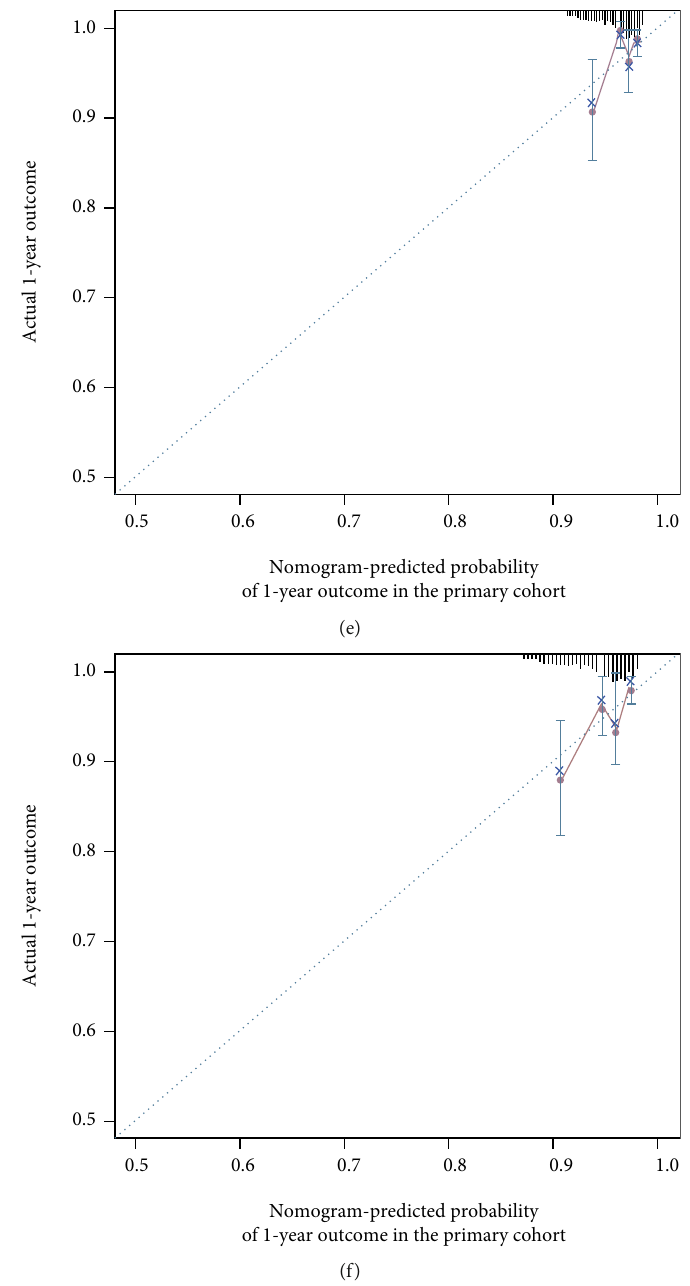
Figure 3: The calibration curve for predicting patient outcome at (a) 1 year, (b) 2 years, and (c) 3 years in the primary cohort, and at (d) 1 year, (e) 2 years, and (f) 3 years in the validation cohort. Nomogram-predicted probability of overall outcome is plotted on the x -axis; actual overall outcome is plotted on the y